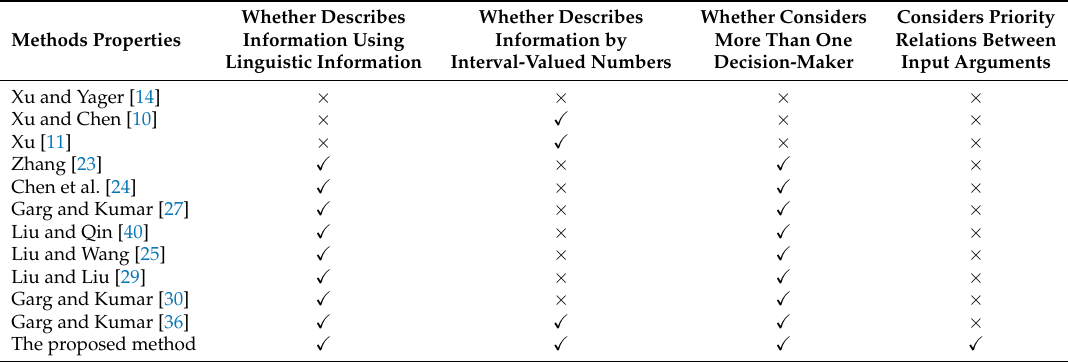
Table 9. The characteristic comparisons of different